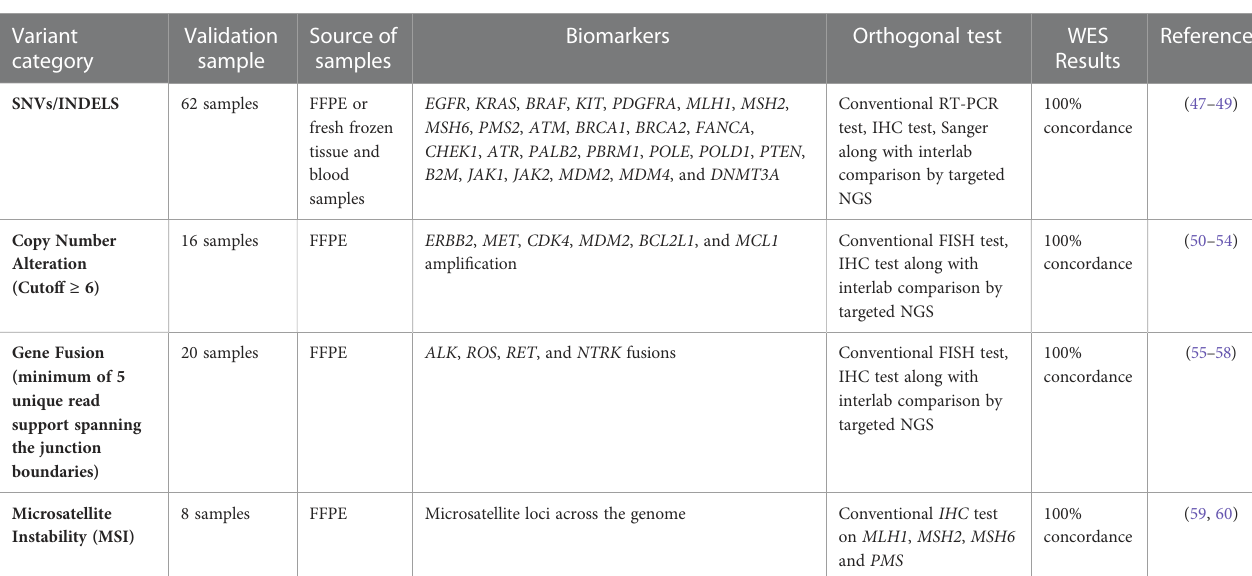
TABLE 1 Clinical validation for genomic alterations using WES (DNA and RNA)- based